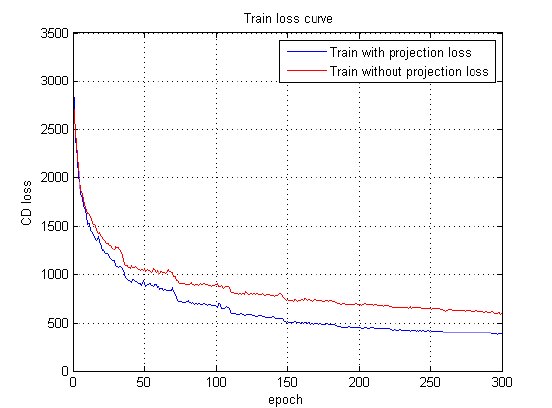
Figure 9. Comparison on training loss curve. The red line displays the training process without projection loss, and the blue line is with projection loss.